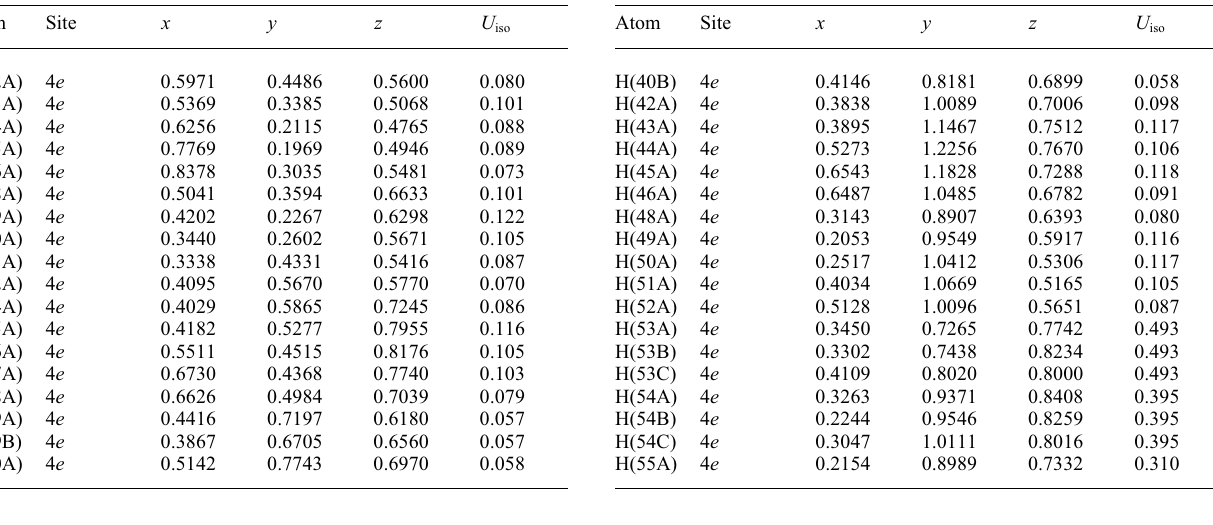
Table 3. Atomic coordinates and displacement parameters (in Å 2